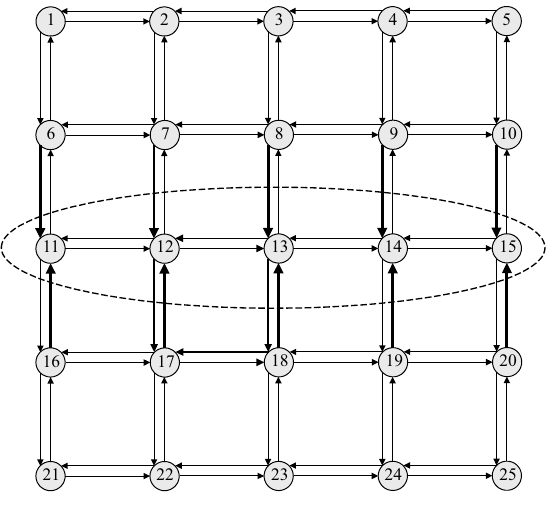
Fig. 11. Optimal charging cordon design